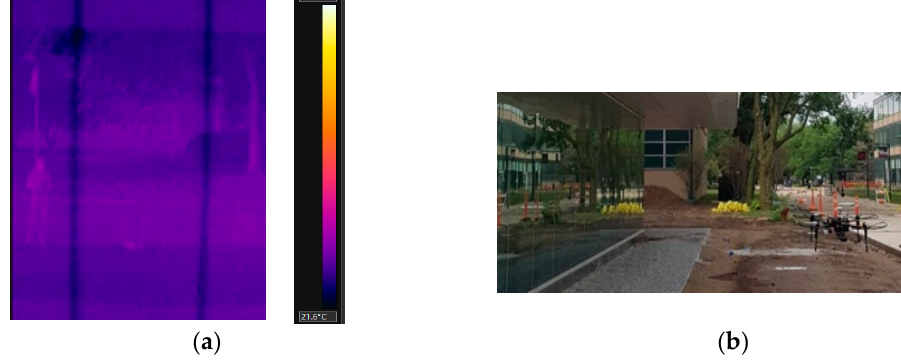
Figure 6. Collecting noncontact temperature from the building envelope using UAV. ( a ) Frame of thermal image; and ( b ) data collection using UAV.